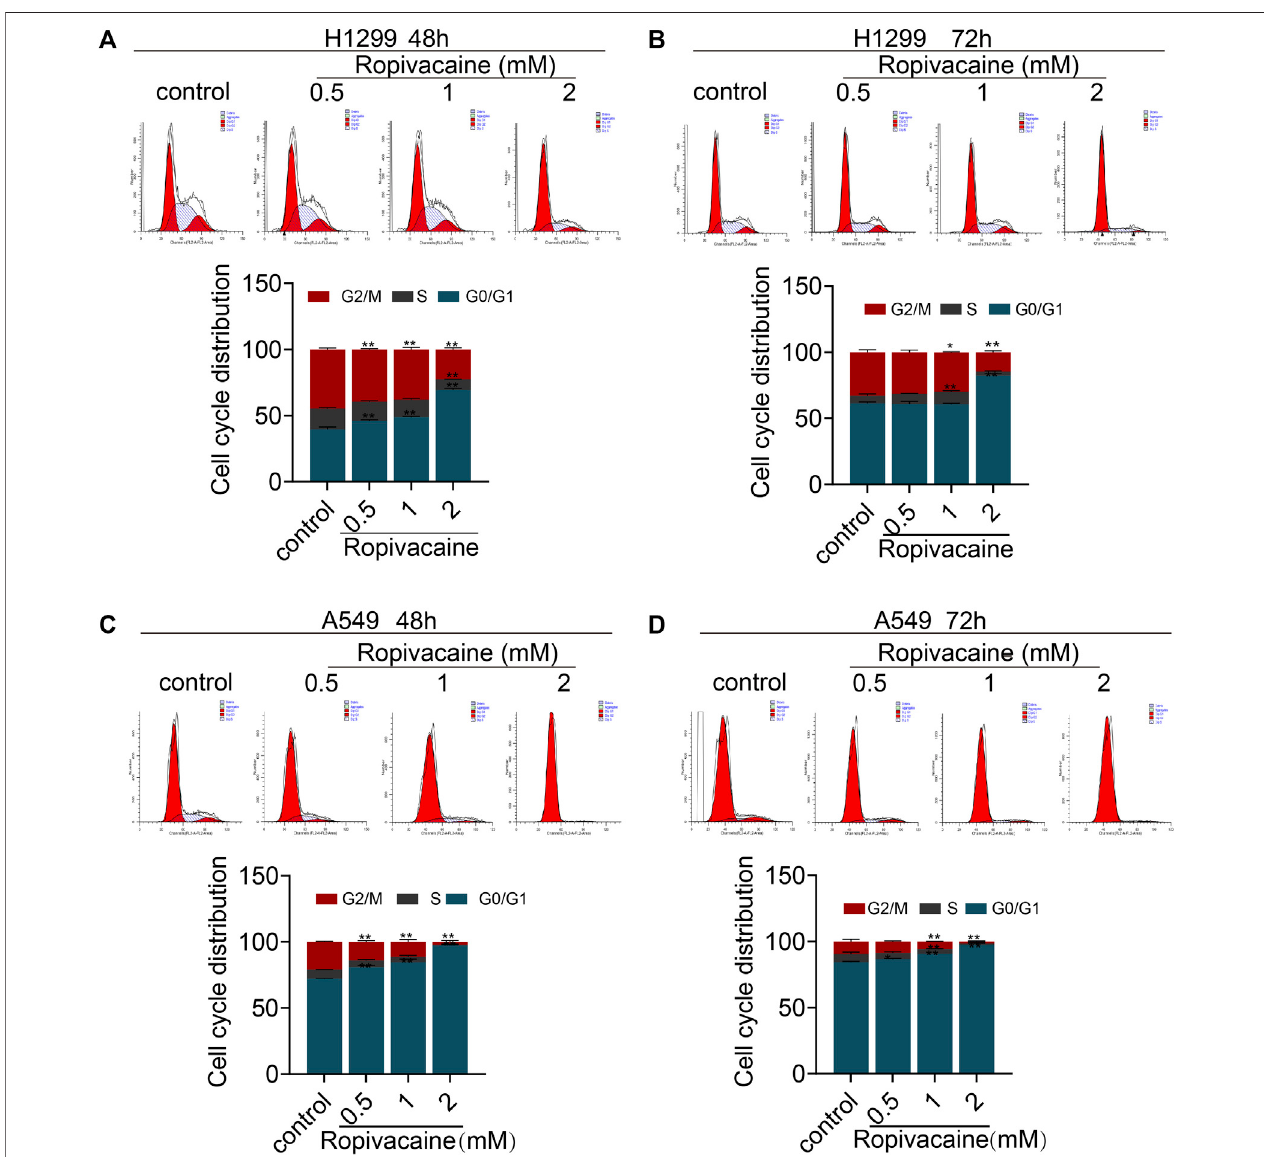
FIGURE 2 | Cell cycle changes induced by ropivacaine. H1299 cells (A , B) and A549 cells (C , D) were treated with different concentrations of ropivacaine for 48 or 72 h. The cell cycle distribution was measured with PI staining and assessed with fl ow cytometry. Data are presented as the mean ± SD from three independent experiments. * p < 0.05 and ** p < 0.01 vs.